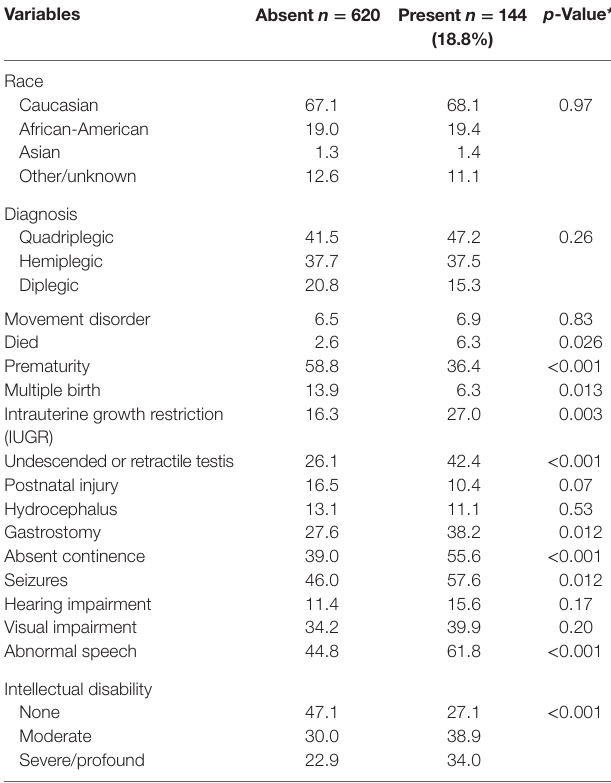
TaBle 5 | Frequencies (%) of subtypes and comorbidities in boys with cerebral palsy based on presence or absence of congenital anomalies (CNS and/or non- CNS) other than cryptorchidism.